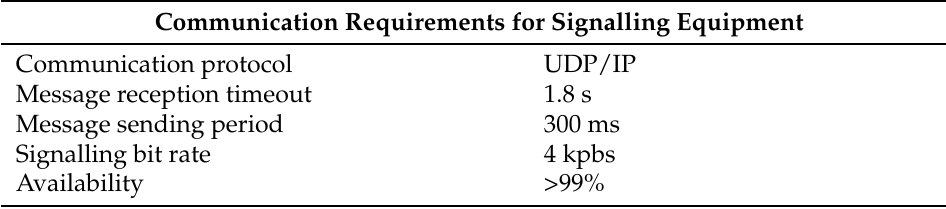
Table 1. Communication requirements for railway signalling